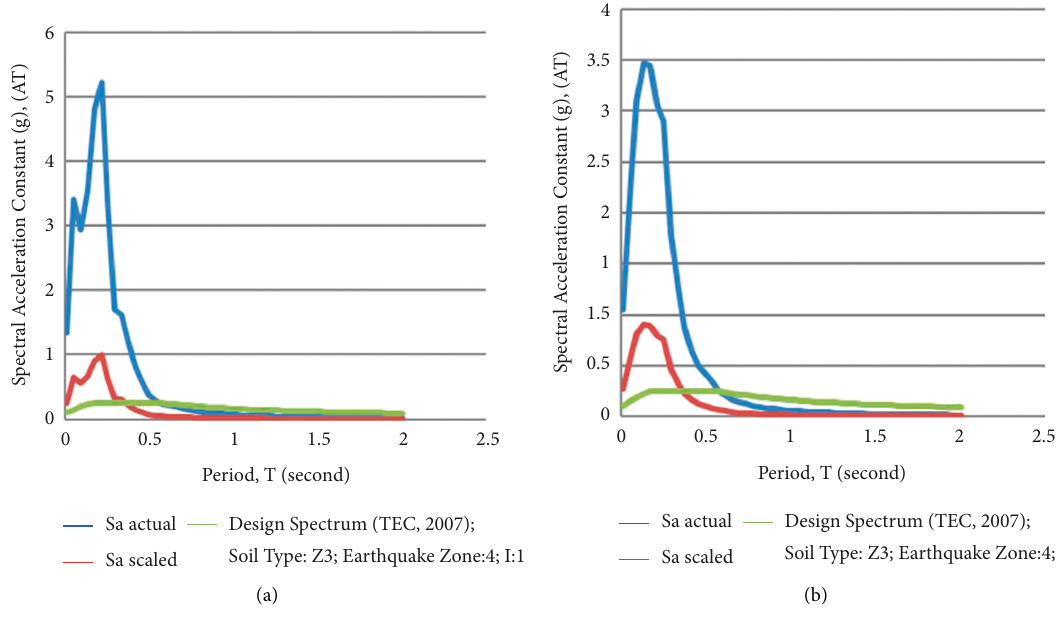
Figure 23: Evaluation of A(T) spectral acceleration constants for (a) North-South (N-S) and (b) East-West (E-W) components of earthquake with epicenter at Nigde-Camardi ( M L :